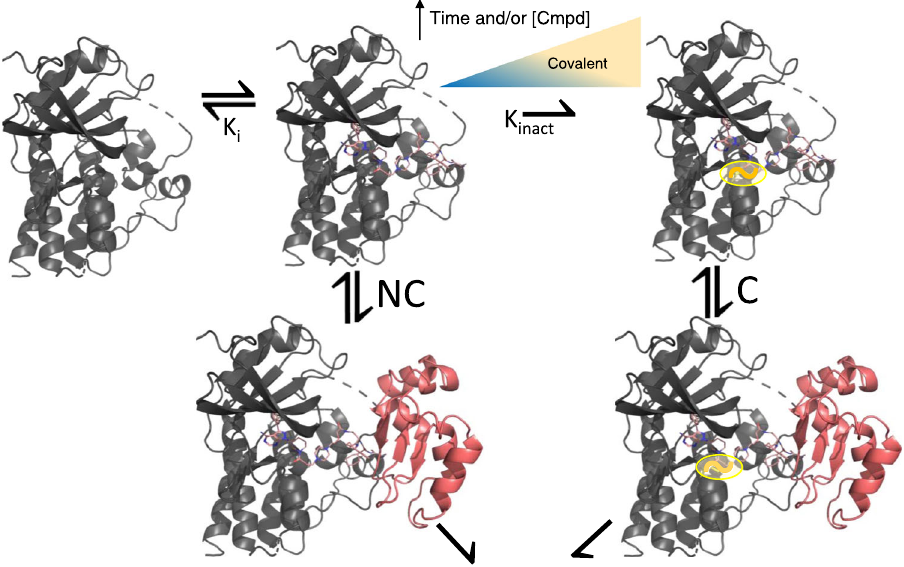
Fig. 6 | ProposedmodelofBTK degradationby BCCov. BTKbindingto BCCovis irreversible covalent modi fi cation (K inact ) by BCCov. The blue/yellow coloring sig- fi rstareversibleeventK ni fi es the tendency of BTK to followeither a non-covalent or covalent degradation i .PathwayNCshowsthe ubiquitinationanddegradationof pathway. It is represented as a gradient as the precise contributions of each path- the non-covalent [BTK-BCCov] complex. Alternatively, pathway C shows the ubi- way may vary with exposure time and compound quitination and degradation of a covalent [BTK~BCCov] complex that follows